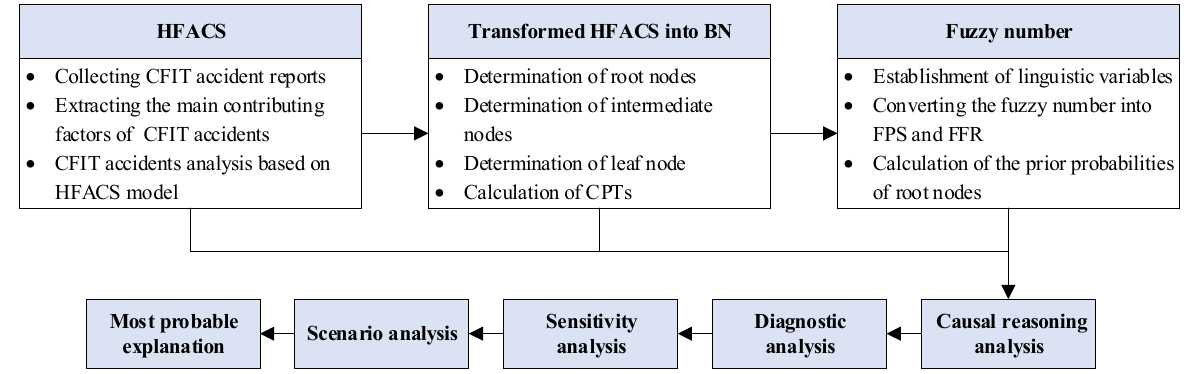
Figure 3. The process diagram of the proposed methodology used in the present study.